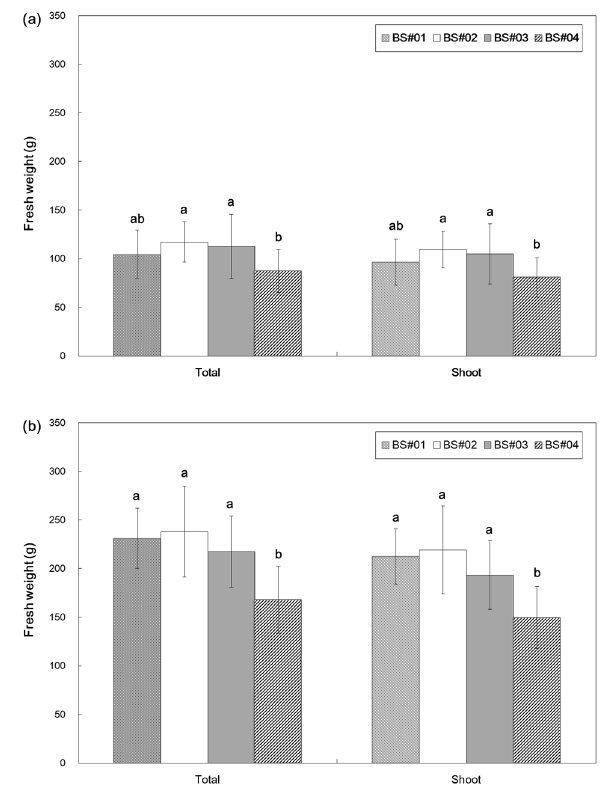
Figure 5. E ff ect of saline irrigation water on lettuce shoot and total fresh weights after the ( a ) first and ( b ) second phases of the experiment. Bars represent the mean ± standard deviation, n = 20. Di ff erent letters indicate significant di ff erences among treatments by Tukey’s honest significant di ff erence test at p < 0.05. BS: before water treatment using the BWD system, i.e., saline water irrigation. In the experiment with desalinated water, no significant di ff erences in total and shoot fresh